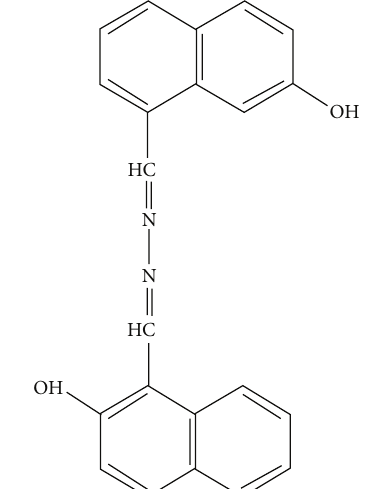
Figure 6: Chemical structure formula of Lumogen